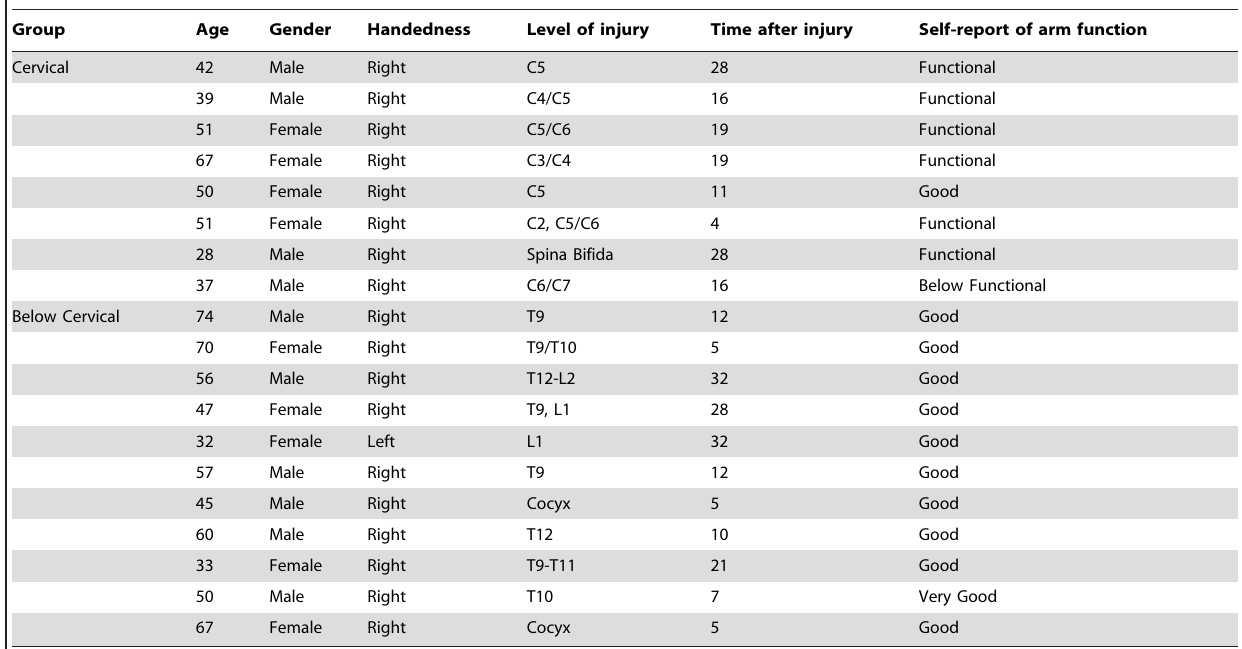
Table 2. Demographic data of the participants.